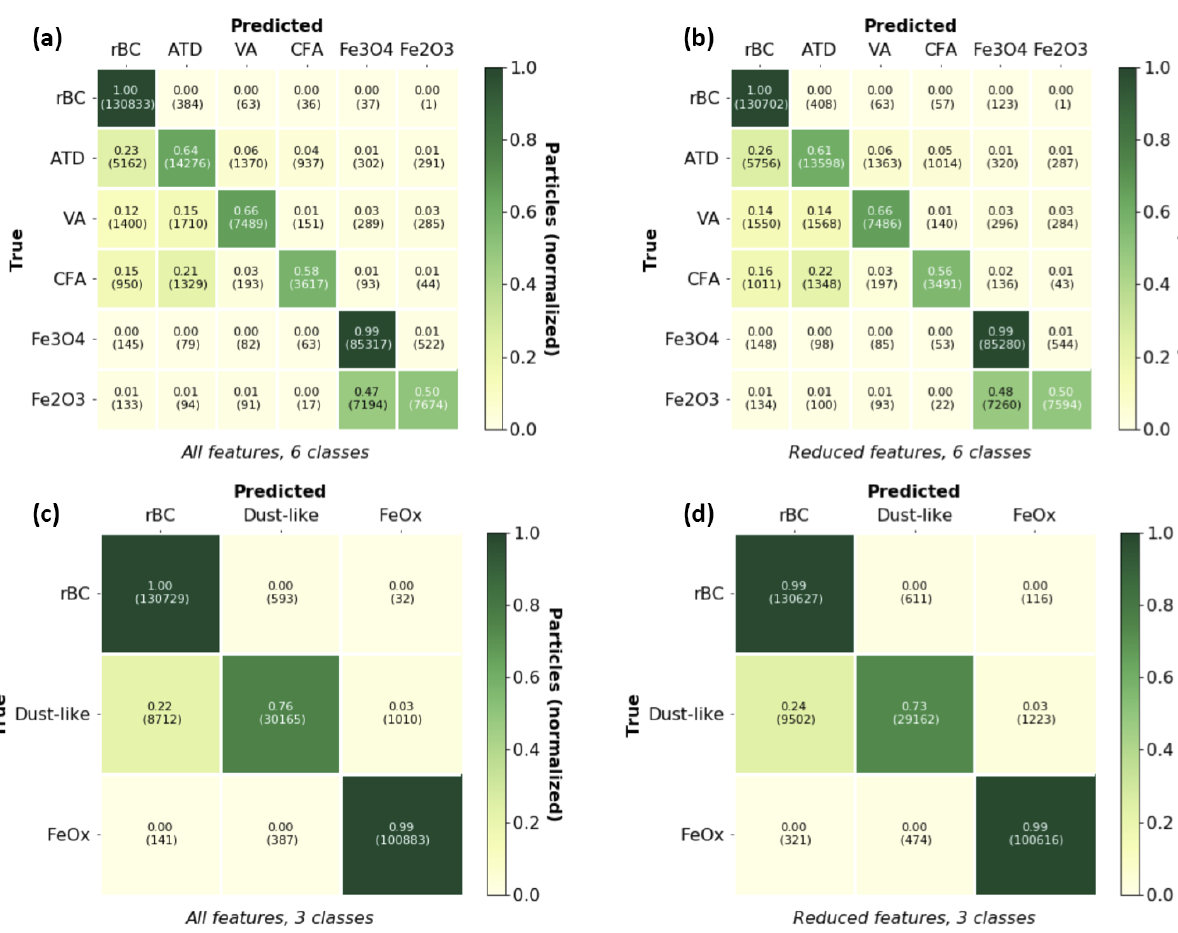
Figure 6. Confusion matrices for the six-class and three-class cases. A visualization of the confusion matrices using all features (a) and the reduced-feature space (b) is shown for the laboratory test data.The y axis in each figure indicates the true particle type and the x axis indicates the particle type predicted by the trained random forest on the test data set. The fraction of aerosols identified as a particular class relative to the total number of aerosols is given, with the actual number of particles shown in